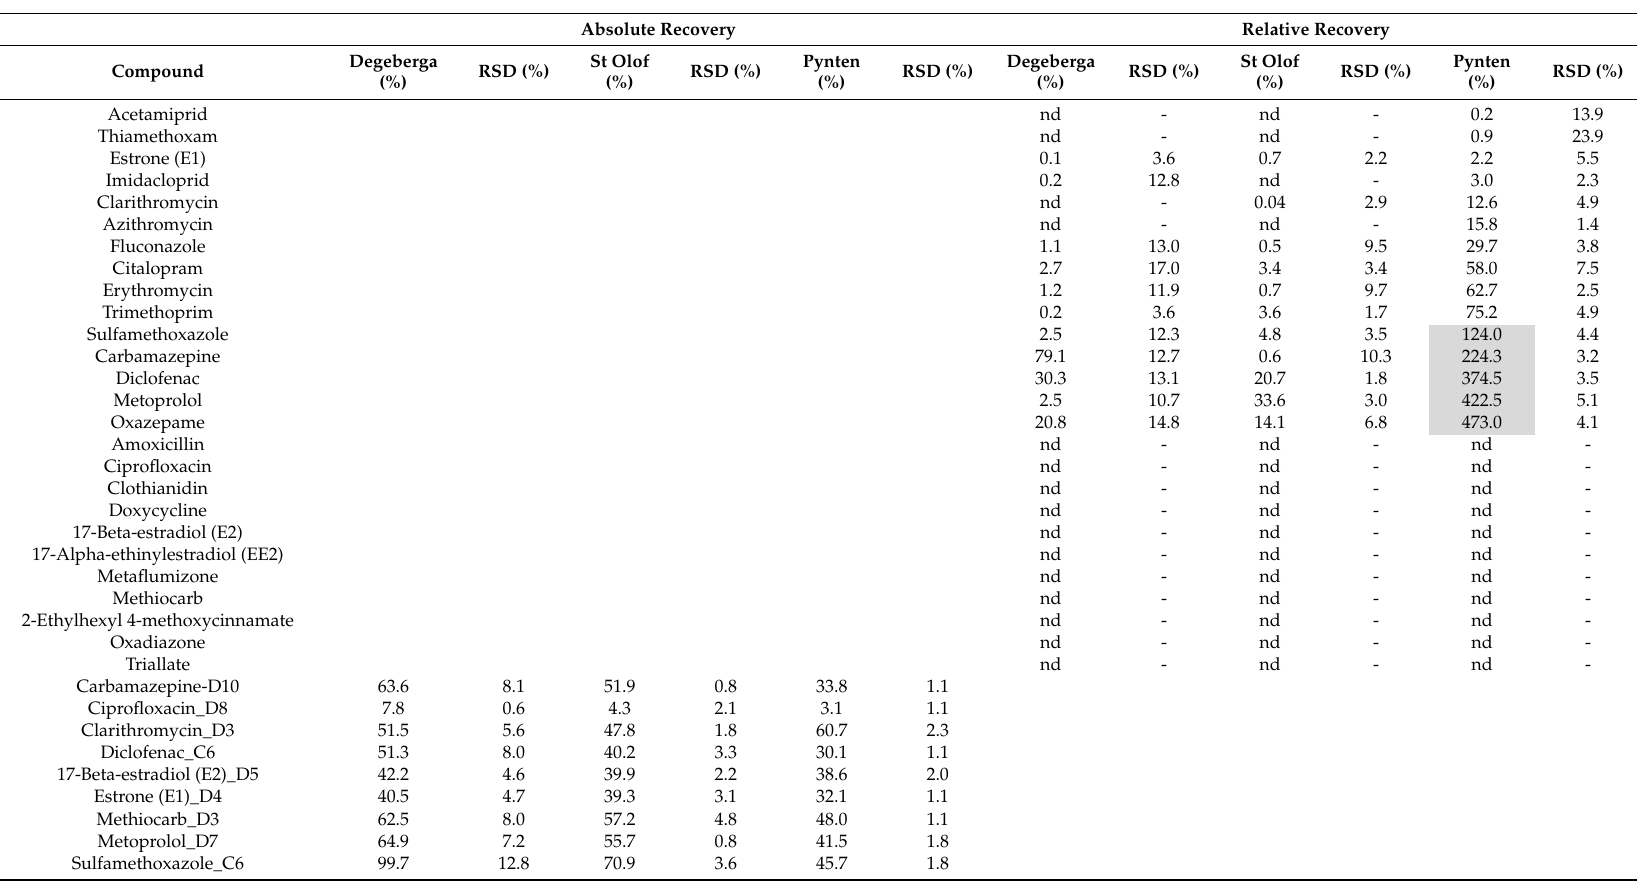
Table 3. Results for the 26 investigated compounds in recipient samples at three different natural locations: Degeberga, St Olof and Pynten. Each recipient water sample was previously processed in triplicates applying a flow rate of 40 mL/min. The results are presented based on findings in Pynten (close to the city of Kristianstad), ranging from the highest to lowest concentration. Five compounds displayed concentrations above 100 ng/L, light grey. The sampling locations can be seen in Figure